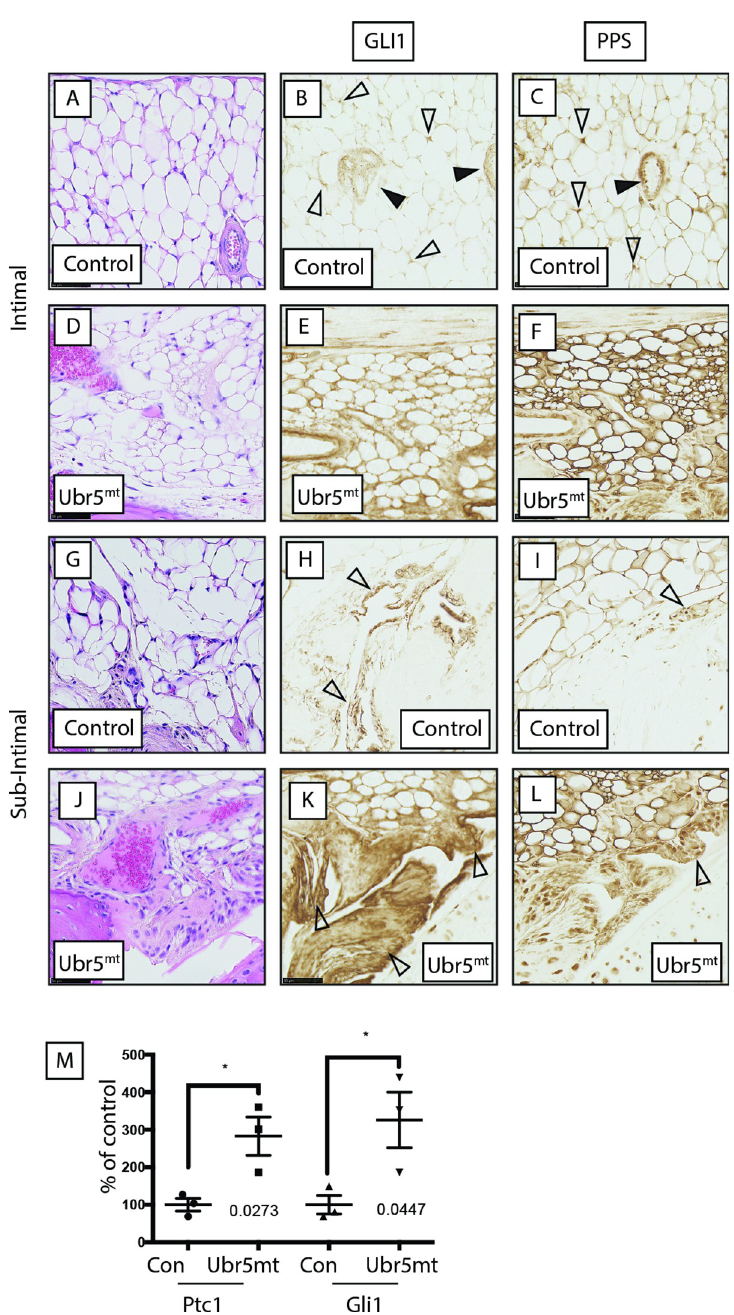
Fig 7. Ubr5 mt synovium exhibits markers of increased canonical and decreased non-canonical HH signalling. Immunohistochemical localization of markers of canonical and non-canonical HH signalling (A-L) six-week-old sagittal sections of Prx1-Cre control (Con) and Ubr5 mt animals. In general, control (A-C) intimal and (G-I) subintimal layers exhibited weaker GLI1 and PPS staining than in comparable Ubr5 mt sections (D-F and J-L, respectively). (B) GLI1 staining in the control intimal layer was located to the vasculature (closed arrowheads) and some adipocytes (open arrowheads). (C) PPS staining was in the vasculature (closed arrowheads) and within adipocytes (open arrowheads). (E) GLI1 and (F) PPS staining were throughout the subintimal layer. (H) GLI1 staining of control synoviocytes within the subintimal layer (arrowhead). (I) PPS staining in sub-intimal layer synoviocytes (arrowhead). (K) GLI1 and (L) PPS staining were strongly expressed within hyperplastic and thickened synovial sub-intimal layer. Synoviocytes exhibited robust nuclear and cytoplasmic staining for GLI1 (K) and PPS (L). (M) qRT-PCR on synovium RNA for expression of canonical HH pathway expression markers Ptch1 and Gli1 . Graph indicates mean and s.e.m. n = three animals. t-test. Ptch1 p = 0.0273 and Gli1 p = 0.0477.